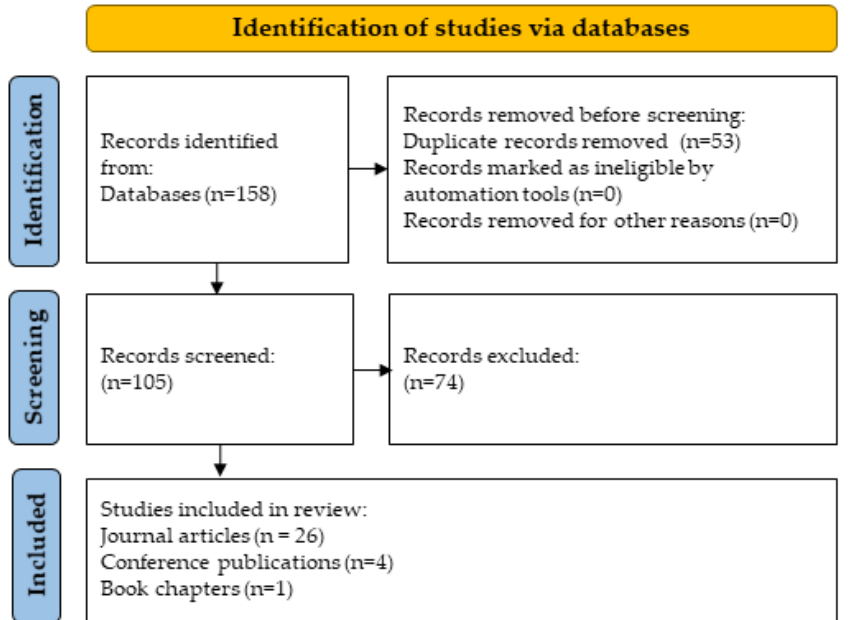
Figure 2. PRISMA flow diagram for new systematic reviews showing the number of documents obtained after each evaluation-step.